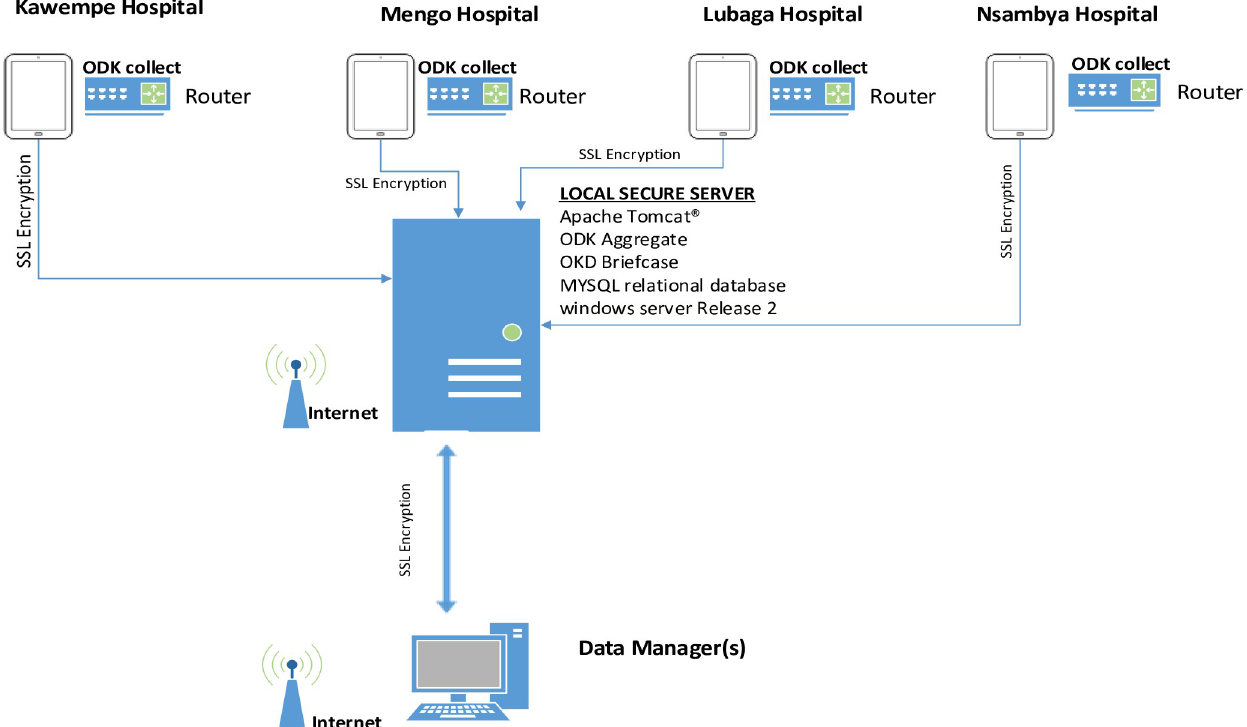
Fig 1. Data flow profile of the surveillance system from the four participating hospitals.